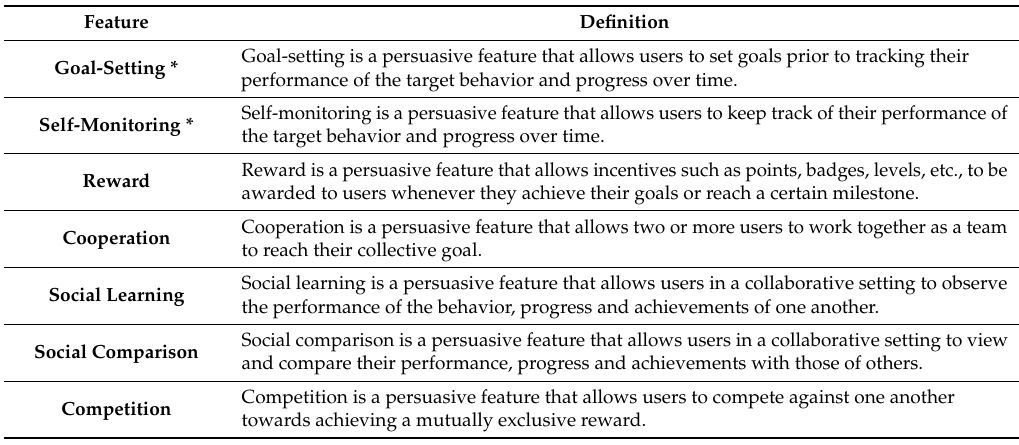
Table 1. Commonly employed persuasive features in persuasive applications and their definitions [12,13,19,20]. The “*” indicates that, in our storyboards, we implemented goal-setting and self-monitoring as a single feature as we considered both as complementary features and discussed them as such in the